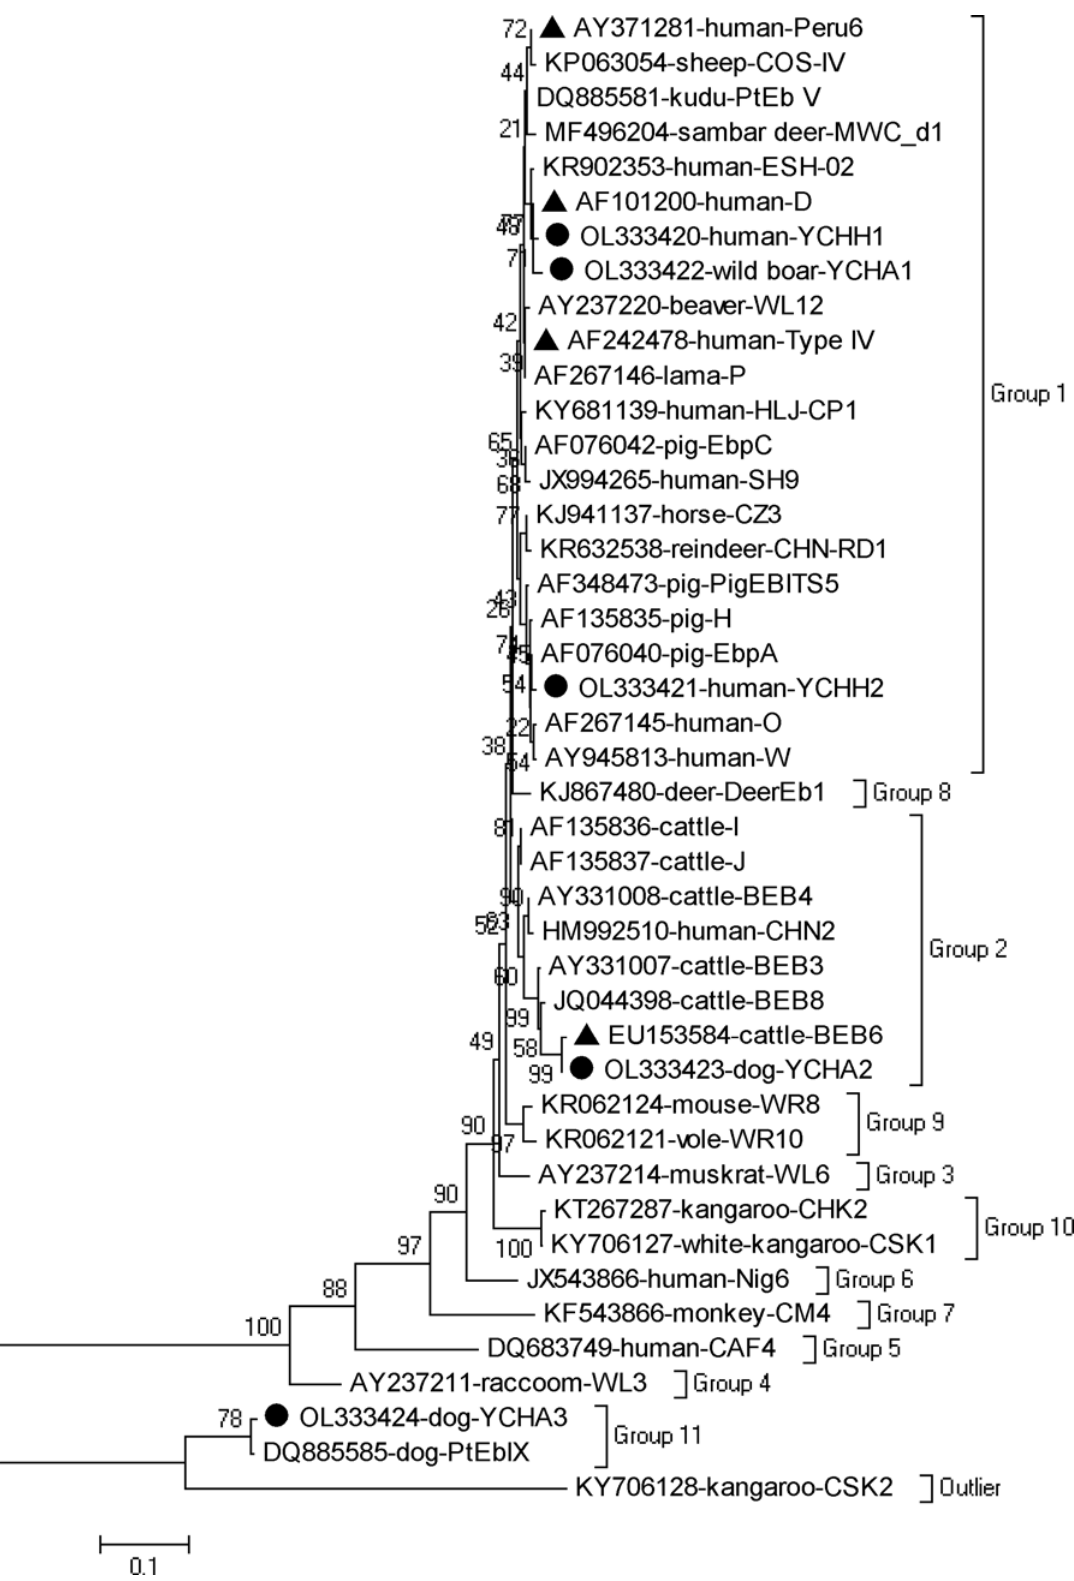
Figure 1. Phylogenetic relationships of the E. bieneusi genotypes of E. bieneusi identi fi ed in this study and other known genotypes as inferred by a neighbor-joining analysis of ITS sequences based on genetic distances calculated by the Kimura 2-parameter model. The numbers on the branches are percent bootstrapping values from 1000 replicates. Each nucleotide sequence is identi fi ed by its accession number, host origin, and genotype designation. The black triangles and circles are known and novel genotypes identi fi ed in this study,